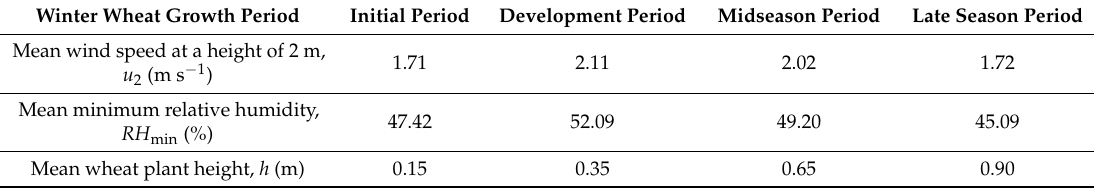
Table 3. Climatic conditions at the experimental site and wheat plant heights during four